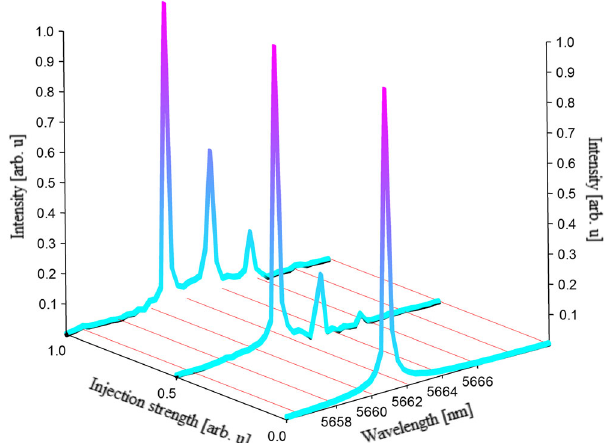
Fig. 4 Optical spectrum evolution during the coupling process. Optical spectrum of the slave laser when it is biased at 512.4mA and for several levels of injection from the master laser. The QCL is monomode under free- running operation and when increasing the injection strength, a second mode is appearing with a subsequently following third mode. The amplitude of these side modes increases with the injection strength while the main mode remains